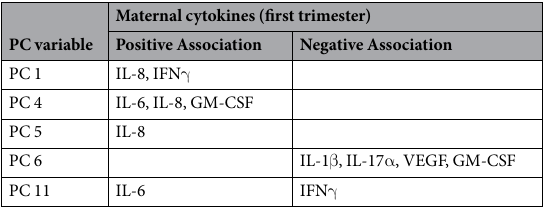
Table 4. Association of EDC mixtures with first trimester cytokines.